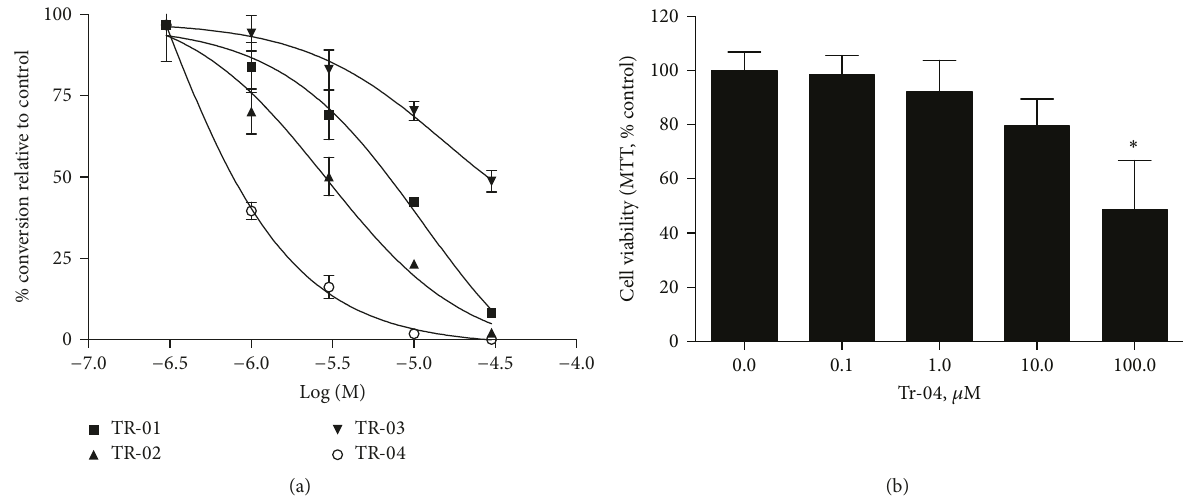
Figure 4: Tetrahydrothiazolopyridine derivatives TR-01–4 inhibited 11 𝛽 -HSD1 oxoreductase activity in the mature 3T3-L1 adipocytes. Cells were treated for 2 h with 0–100 𝜇 M of the test compounds and incubated in DMEM containing cortisone (1 𝜇 M) for 20 min. The resulting metabolite/conversion ratios were measured by LC-MS. Data are the mean ± SEM ( 𝑛 = 3 ). ∗ 𝑝 < 0.05 versus vehicle by Dunnett’s test subsequent to one-way